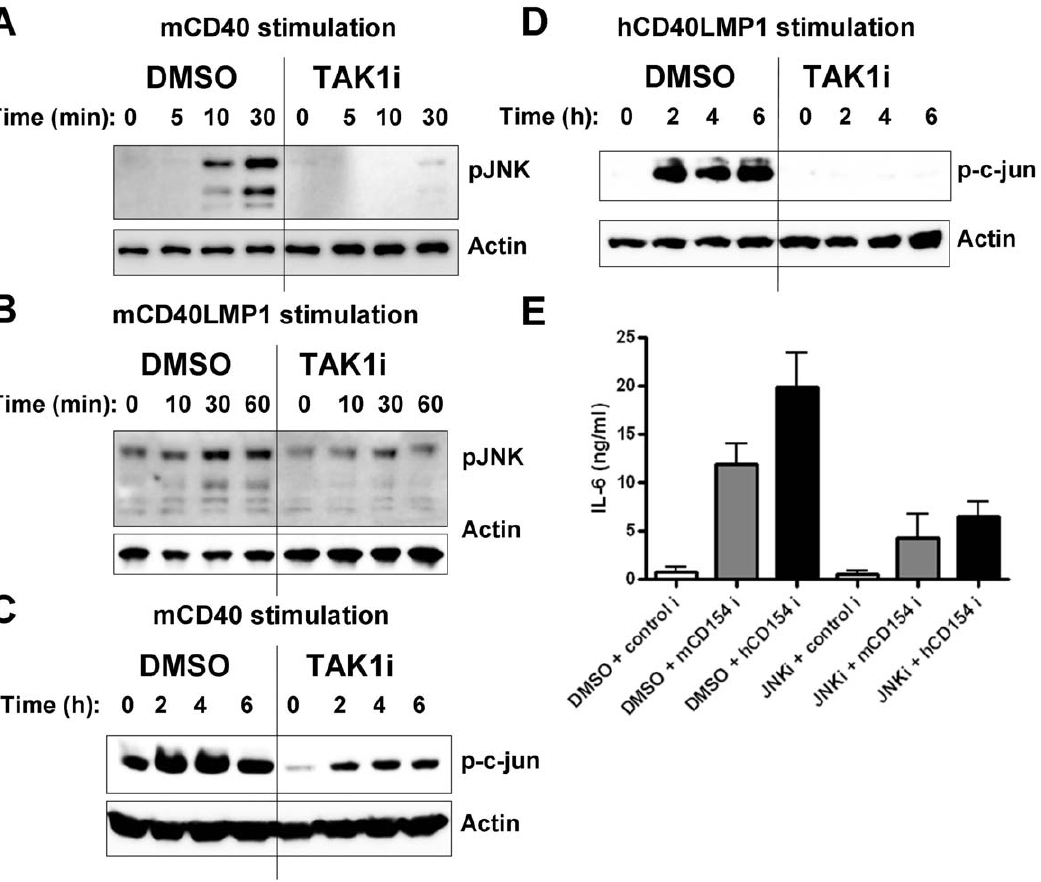
Figure 4. Requirement for TAK1 in CD40- and LMP1-mediated activation of the JNK pathway. A) WT mouse splenic B cells were treated with DMSO or TAK1i for 30 min prior to stimulation with anti-mCD40 Ab for 0, 5, 10, or 30 min. Western blots show protein levels for pJNK, with actin as a loading control. B) Similar to panel A , except that splenic B cells from a mCD40LMP1 Tg mouse were stimulated for 0, 10, 30, or 60 min. C) Mouse CH12.LX B cells were treated with DMSO or TAK1i for 30 min prior to stimulation with anti-mCD40 Ab for 0, 2, 4, or 6 h. Western blots show p-c-jun, with actin as a loading control. D) Similar to panel C , except that CH12.hCD40LMP1 mouse B cells were stimulated with anti-hCD40 Ab. Data shown are representative of at least two independent experiments. E) CH12.hCD40LMP1 cells were treated with DMSO or JNKi prior to stimulation with control insect cells (control i) or cells expressing either mCD154 (mCD154 i) or hCD154 (hCD154 i). Cells were cultured for 24 h and supernatants were collected for IL-6 ELISA assay. Data are mean values 6 SEM of triplicate samples from two independent